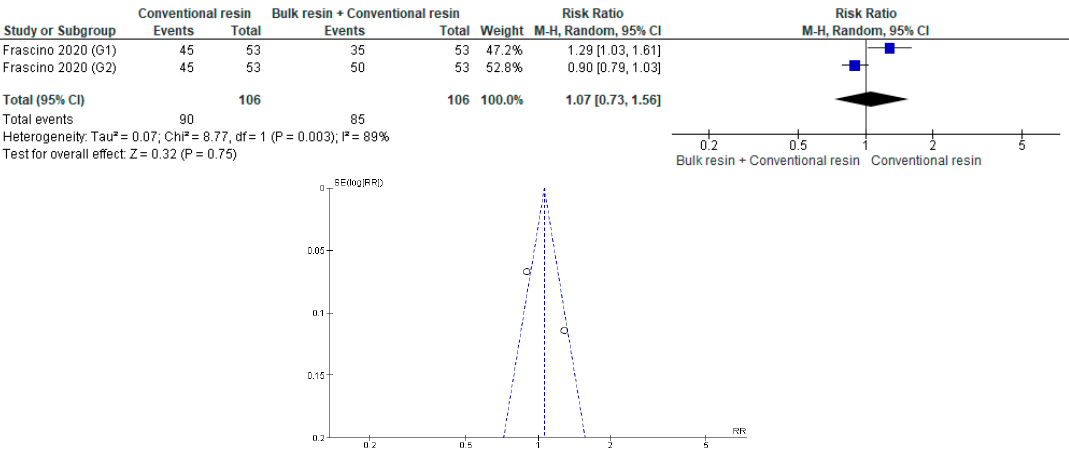
Figure A43. Adequate Restoration Integrity: Conventional Resin versus Bulk Resin Covered with Conventional Resin.